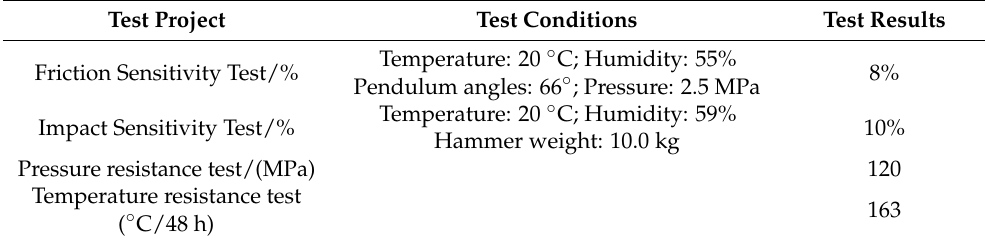
Table 3. Fracturing agent sensitivity, pressure, and temperature resistance test results.